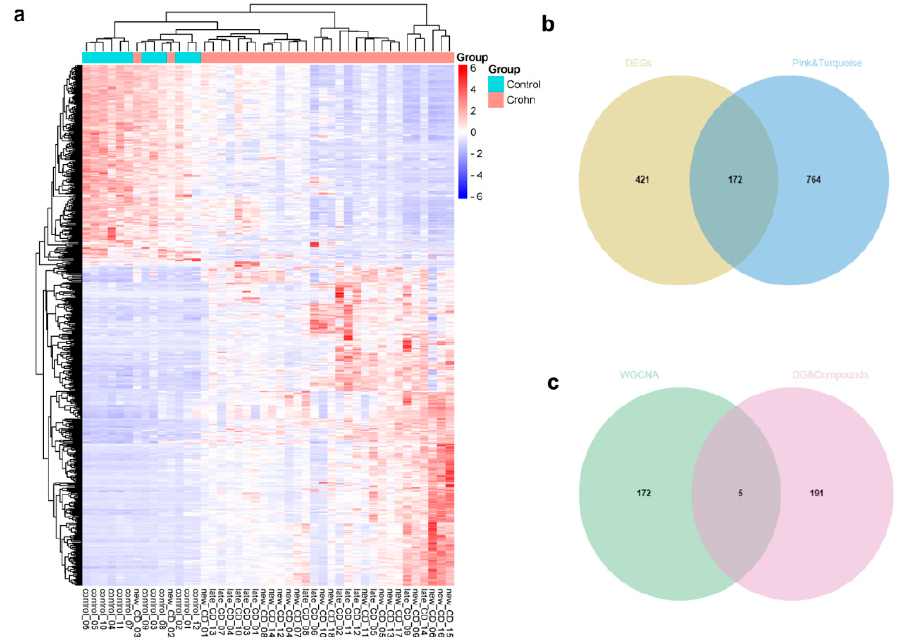
Figure 9. Screening of differentially expressed genes (DEGs) between Crohn’s disease and normal samples. ( a ) Heatmap of DEGs in Crohn’s’ disease. Each small square in the heatmap represents a gene; red indicates an up-regulated gene expression, blue indicates a down-regulated expression, and color shades indicate high or low gene expression rates. Each column represents the expression of genes in each sample, whereas each row represents the expression of each gene in different samples. The upper attribute clustering tree indicates the results of clustering analysis of multiple samples with different groups. ( b ) Venn plot of DEGs and significant modules, and ( c ) Venn plot of DEGs in modules and Dajianzhong decoction targets.